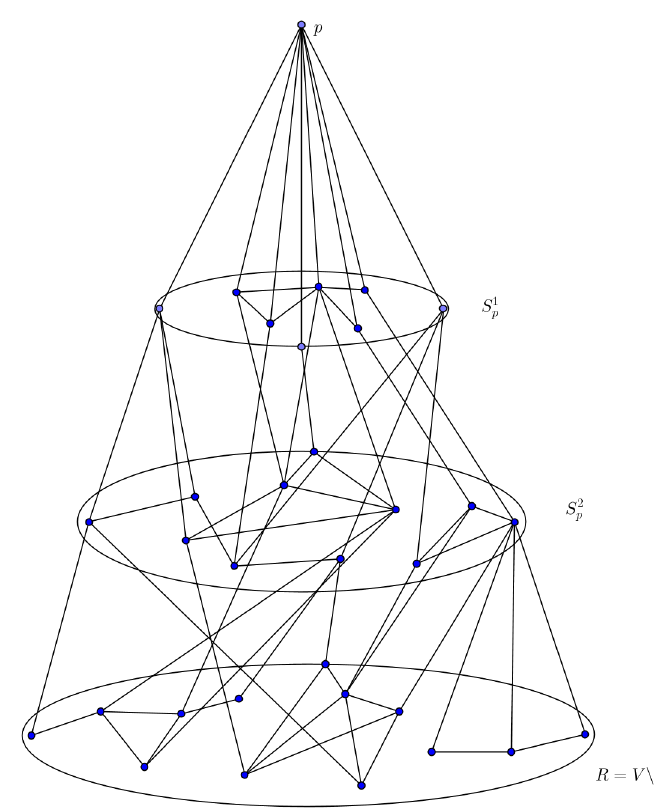
Figure 3: Metric spheres centered at